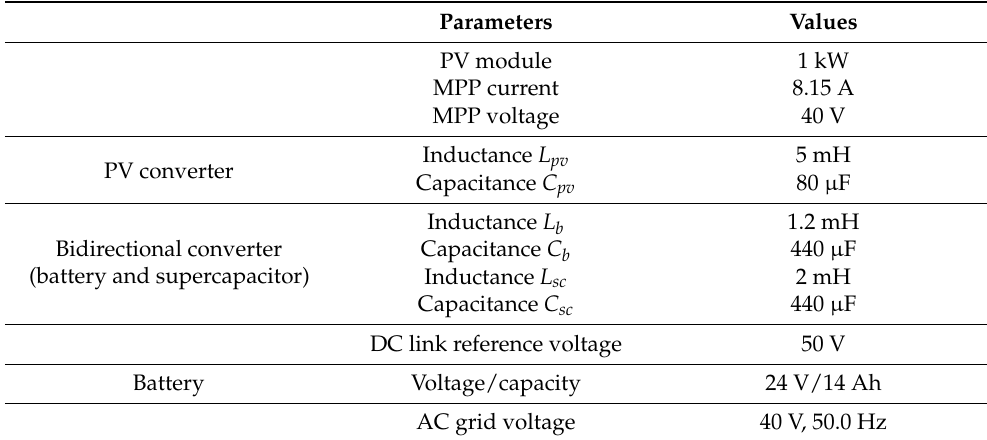
Table 2. Basic specifications for the test